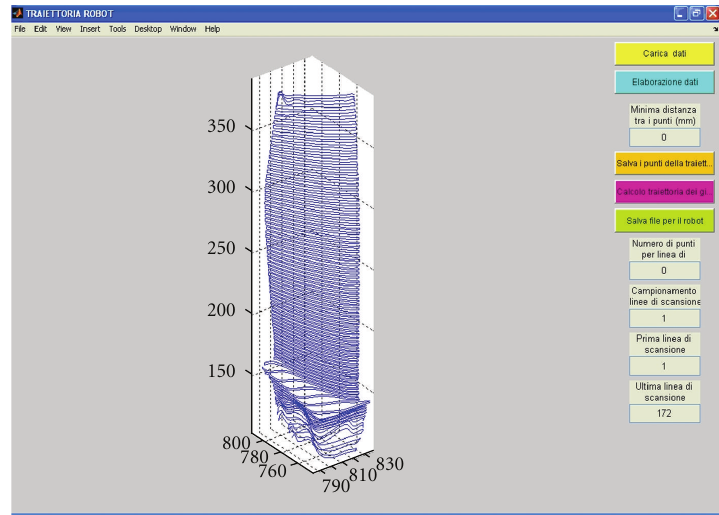
Figure 6: Graphical user interface to control the trajectory